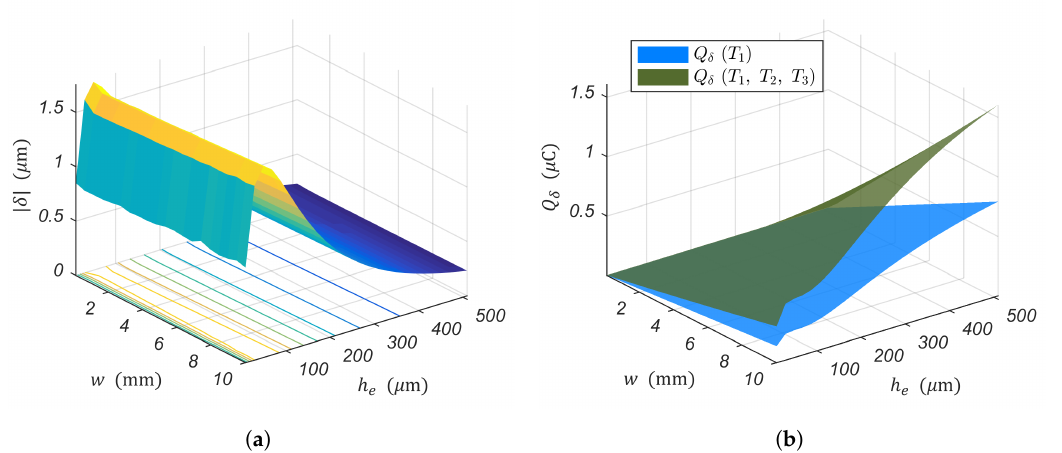
Figure 8. Numerical evaluation of the influence of the varying PEA’s width w and elastic layer thickness h e . ( a ) The piezoelectric actuation. ( b ) The piezoelectric sensor’s sensitivity to strain induced by piezoelectric